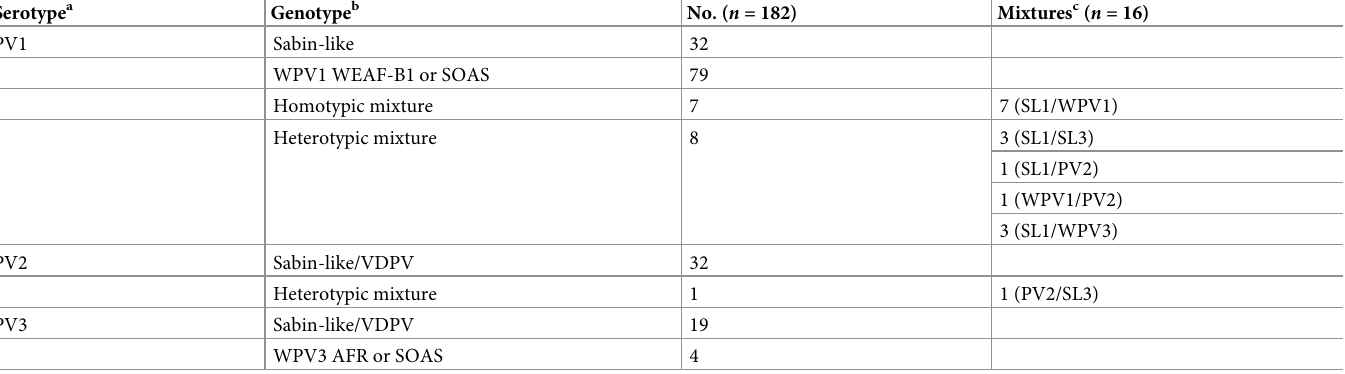
Table 1. Composition of stool specimen collection used for parallel testing by poliovirus serotype and genotype determined prior by virus isolation, ITD and sequencing. Serotype a